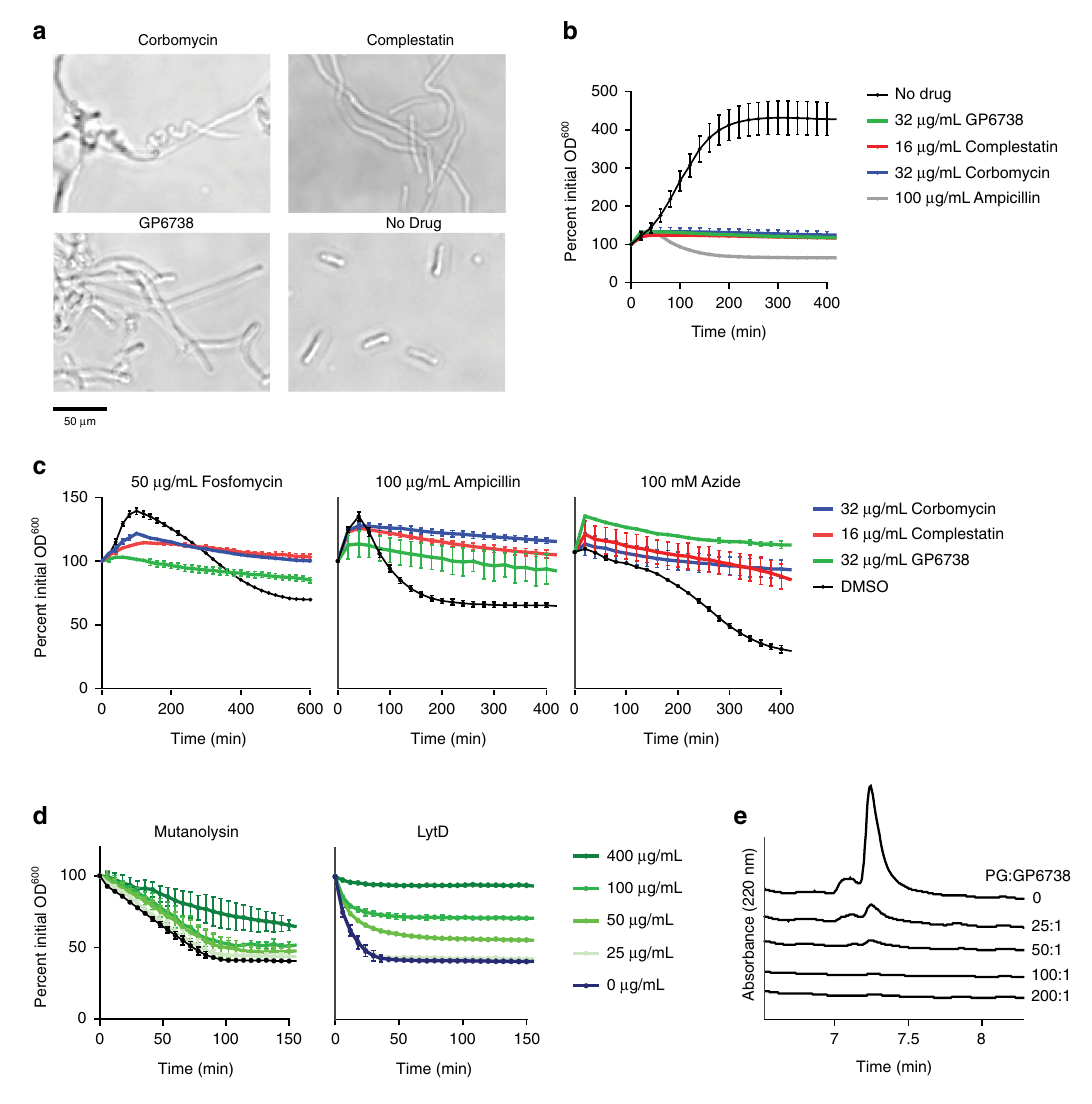
Fig. 5 Mode of action study of GP6738. a Bright fi eld microscopy shows the effect of GP6738 on B. subtilis 168 morphology. Cells were treated with 0.6× MIC antibiotic (0.6 µ g/mL complestatin, 0.6 µ g/mL corbomycin, and 3.2 µ g/mL GP6738) and grown to mid-log phase. b Tracking growth of B. subtilis